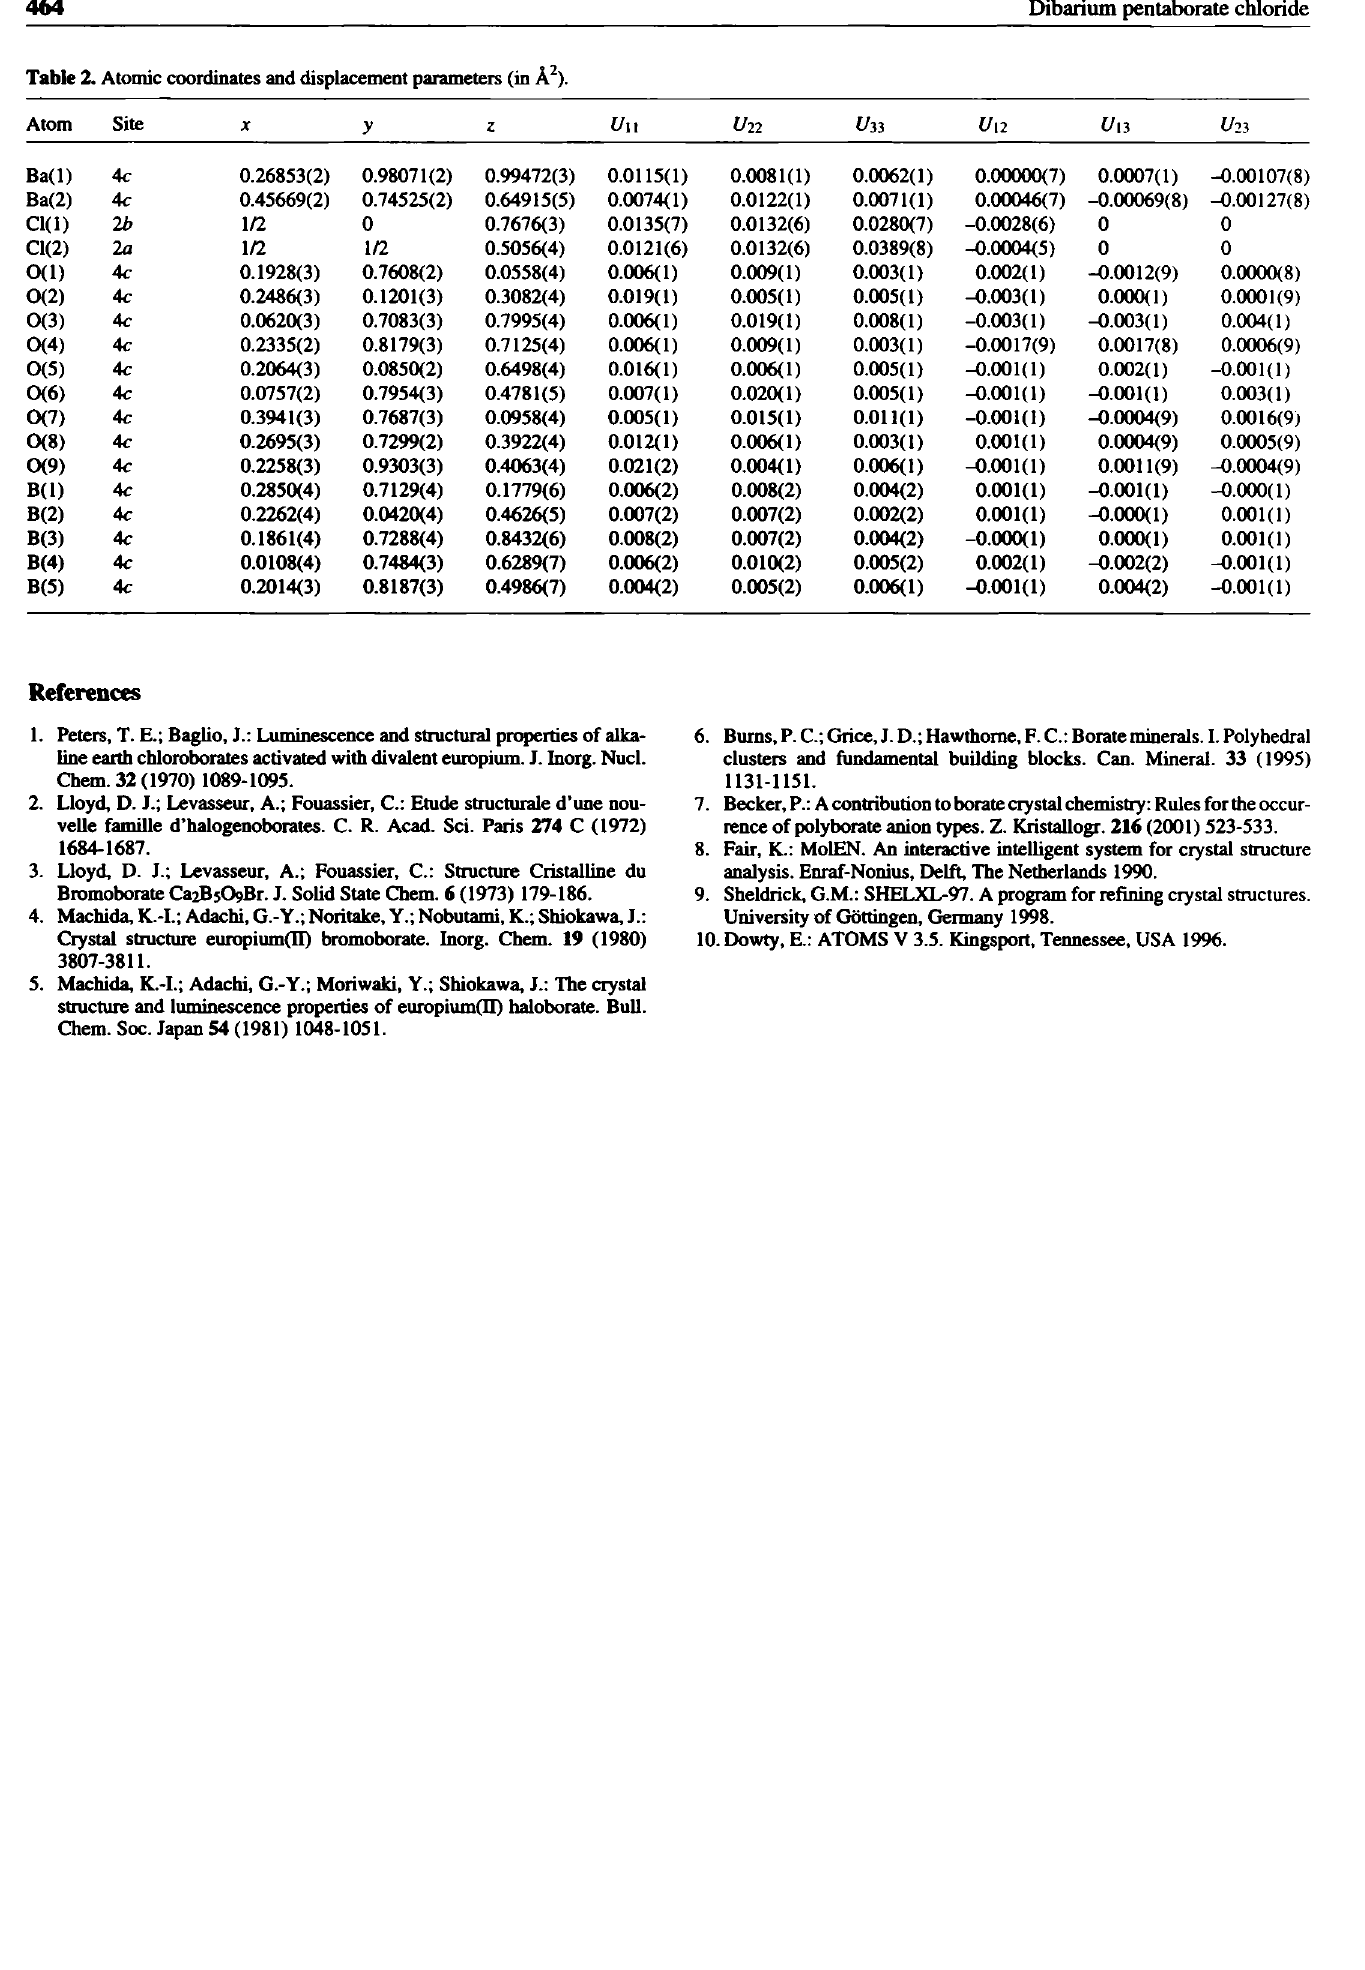
Table 2. Atomic coordinates and displacement parameters (in Â 2